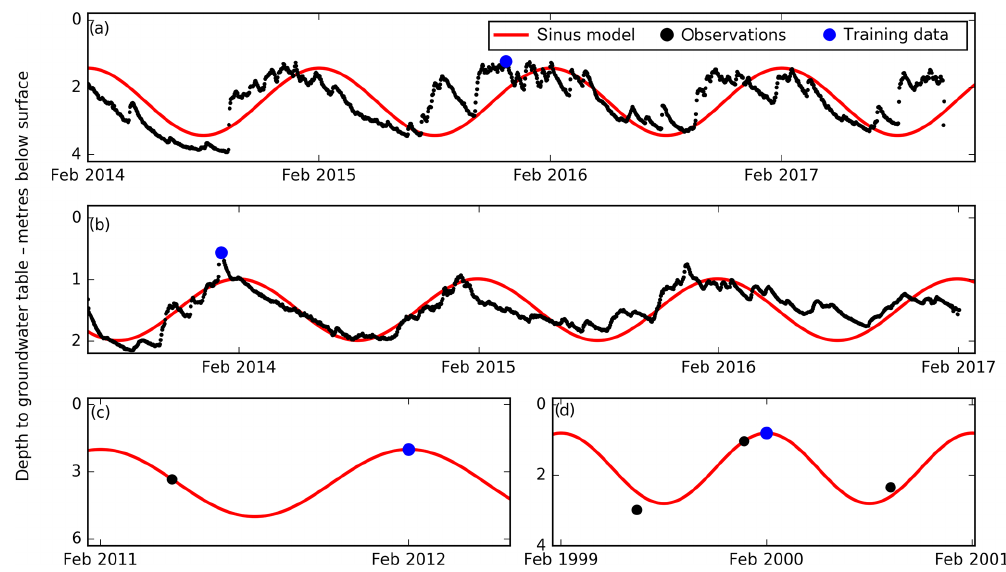
Figure 2. Four examples showing how the training dataset was derived. At wells with more than four observations (a, b) , the minimum daily observation was chosen. Examples (a) and (b) represent long time series and sinus curves with amplitudes of 1 and 0.5m respectively, and were used to describe the annual variability. Examples (c) and (d) represent two cases with few observations. Here, sinus curves with predefined amplitudes, 1.5 and 1m respectively, corresponding to the well’s hydrogeological setting were applied to traverse the observed minimum depth to an expected wintertime